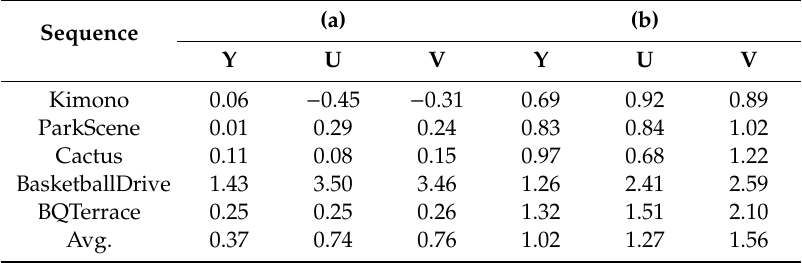
Table 5. Coding performance of (a) the sampling-based intra prediction method [11,12] and (b) the proposed